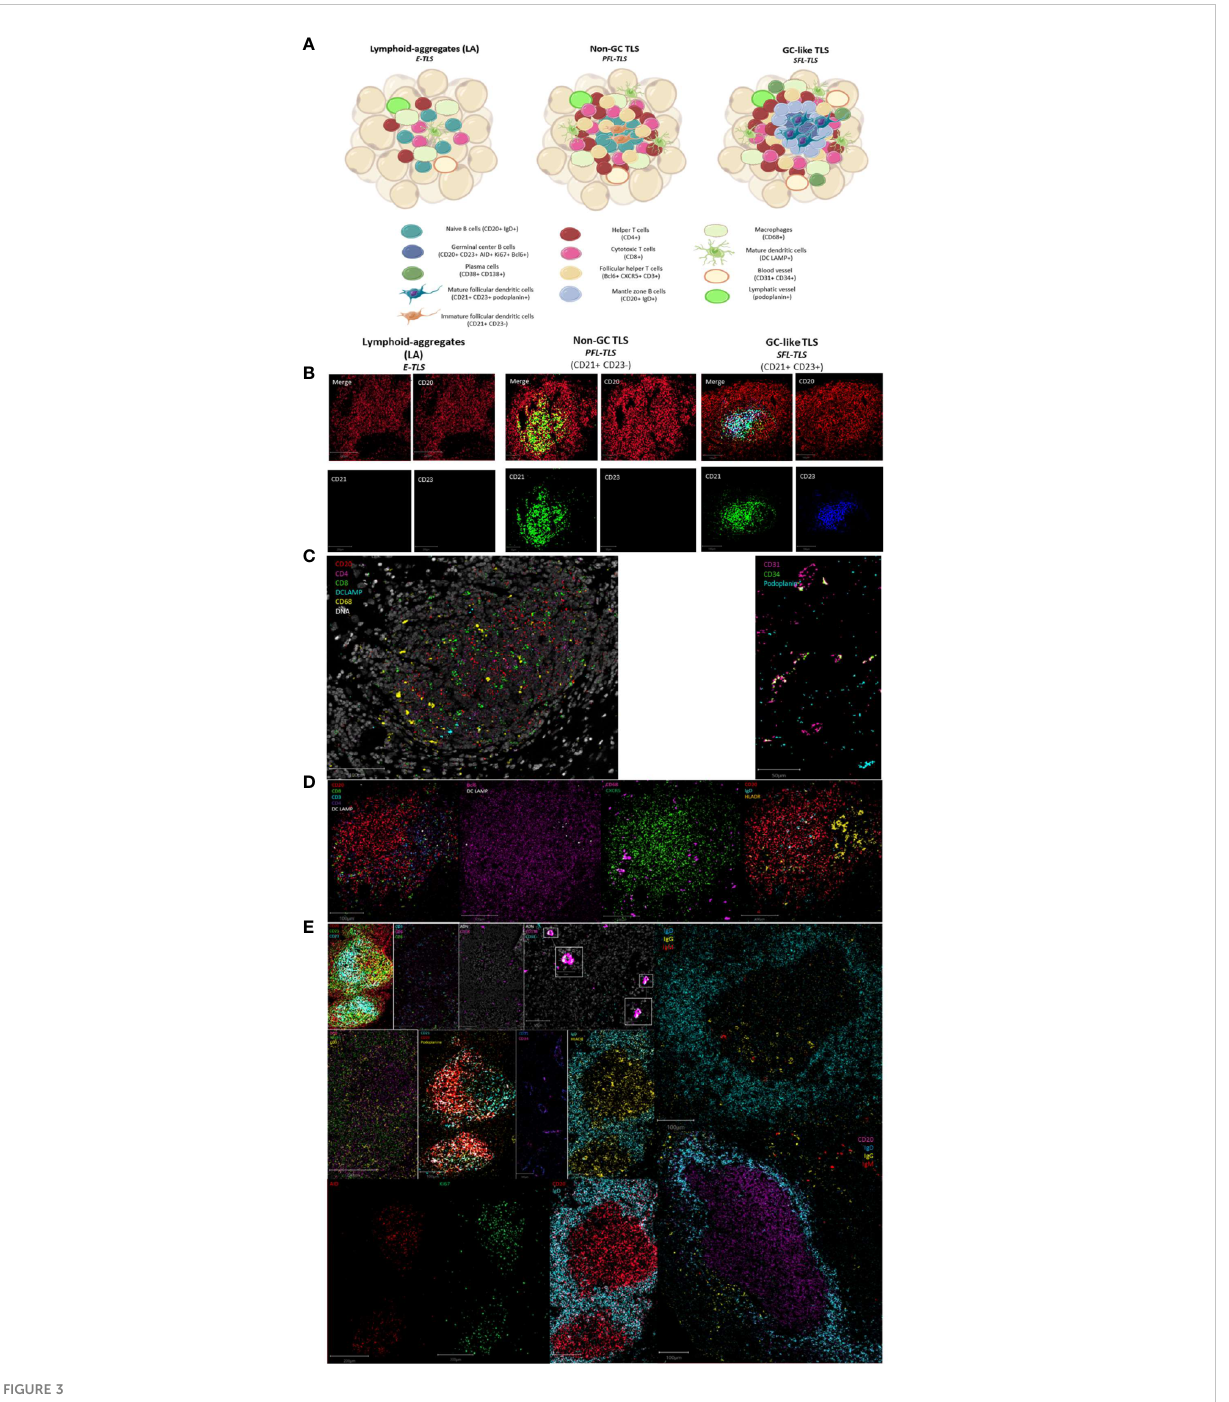
FIGURE 3 Maturation stages of tertiary lymphoid structures. (A) The different stages of tertiary lymphoid structures. Lymphoid-aggregates (LA) constituted of T and B cells, with some macrophages and mature dendritic cells, corresponding to early-TLS stage in Silina ’ s work. Non-germinal center (GC) TLS, corresponding to primary follicle-like TLS, is formed with distinct organized T and B cells zones including follicular dendritic cells in the B-zone. Germinal center (GC)-like TLS, corresponding to secondary follicle-like TLS, is a functional germinal center composed of proliferating mature germinal center B lymphocytes (AID+Bcl6+Ki67+) and follicular dendritic cells (podoplanin+) surrounded by mantle zone B cells (IgD+) and bordered by follicular helper T cells (Bcl6+CXCR5+CD3+). In addition, TLS are formed of CD4+ and CD8+ T cells, plasma cells, mature dendritic cells, and macrophages enriched in the T-zone. (B) Representative images of the IMC markers CD20, CD21 and CD23 characteristics of the three different TLS-stages. Images from the three TLS come from the same Crohn ’ s patient. (C) Representative image of IMC markers found in immune aggregate of a patient with Biermer disease. (D) Representative images of IMC markers found in non-GC TLS of a Crohn ’ s patient. (E) Representative images of IMC markers found in GC-like TLS found in one colonic MSI adenocarcinoma and two gastric MSS samples. White boxes show the plasma cells (CD38+CD138+) appearing as a colocalization of a cyan and a pink